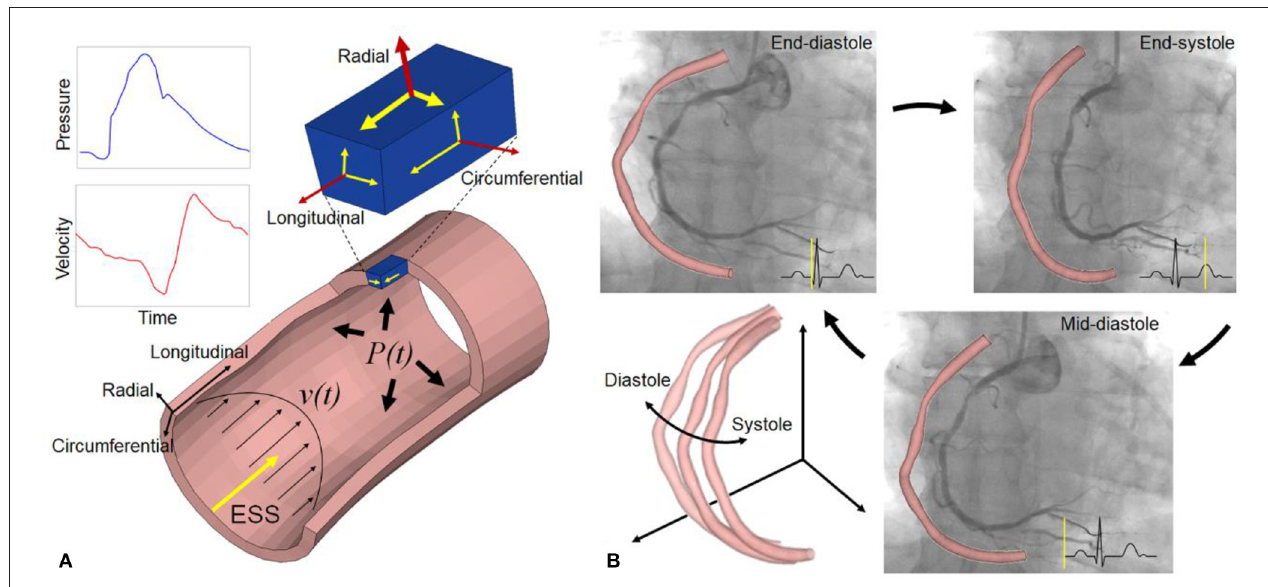
FIGURE 1 | Biomechanical forces and dynamic coronary arterial motion. (A) Time-varying blood flow induces endothelial shear stress (ESS) along the vessel lumen. Radial (normal) strain/stress caused by intraluminal blood pressure is perpendicular to the endoluminal wall (top surface of a small material volume, blue color), and two shear strain/stress couples also exist in circumferential and longitudinal directions on this surface. The volume has two other orthotropic surfaces with strain/stress (small arrows), such that a total of nine components are operative. Red and yellow arrows refer to normal and shear strain/stress, respectively. As an equivalent quantity without direction, von Mises stress and strain, calculated from the nine components, is used to describe the complex multi-dimensional mechanical state for easy understanding and application in clinical fields ( 1). (B) Coronary angiography and 3D geometries at three specific cardiac phases: end-diastole, end-systole, and mid-diastole. It shows the large cyclic motion and deformation of a right coronary artery in 3D